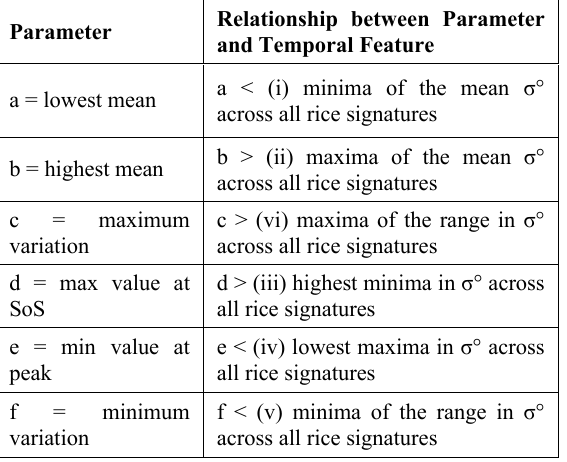
Table.2 Site-specific parameters for the rule-based classification and the criteria used to select them based on temporal features Rice area integration (VV and VH